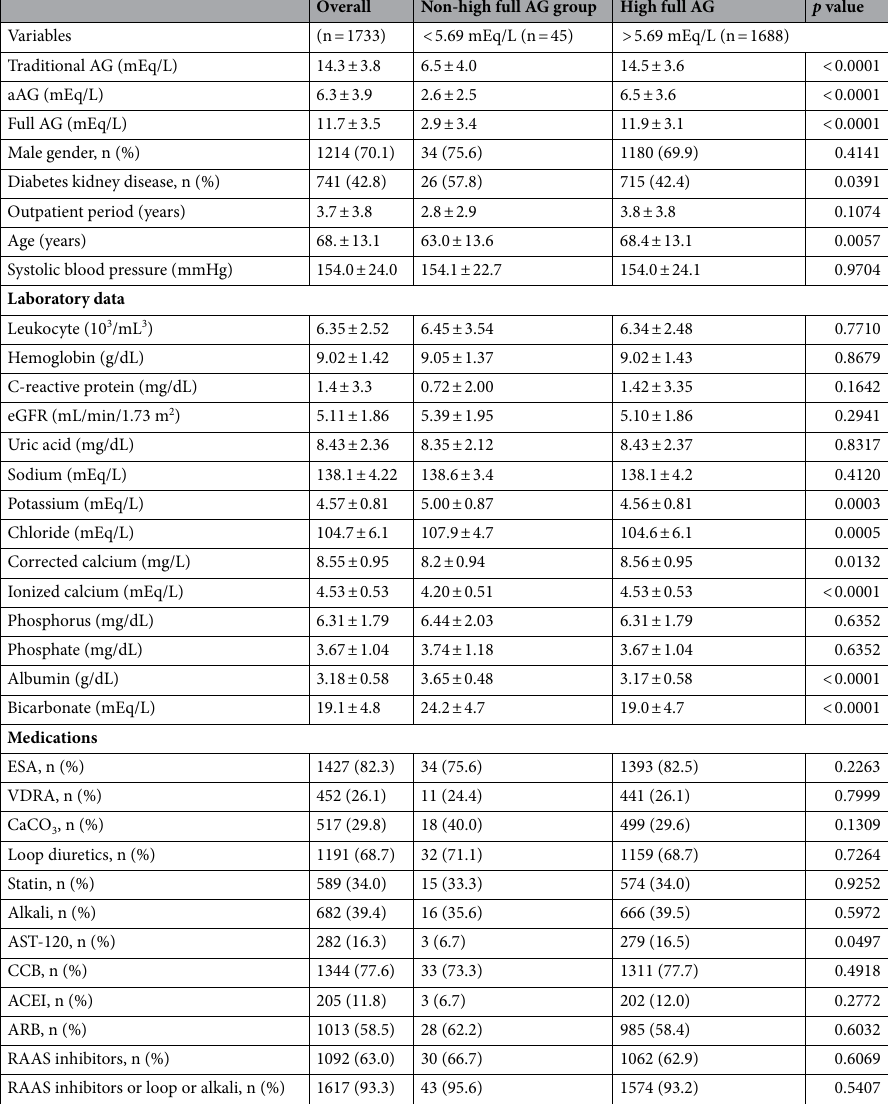
Table 2. Comparison of patient characteristics between the high full AG and non-high full AG groups. aAG albumin-adjusted